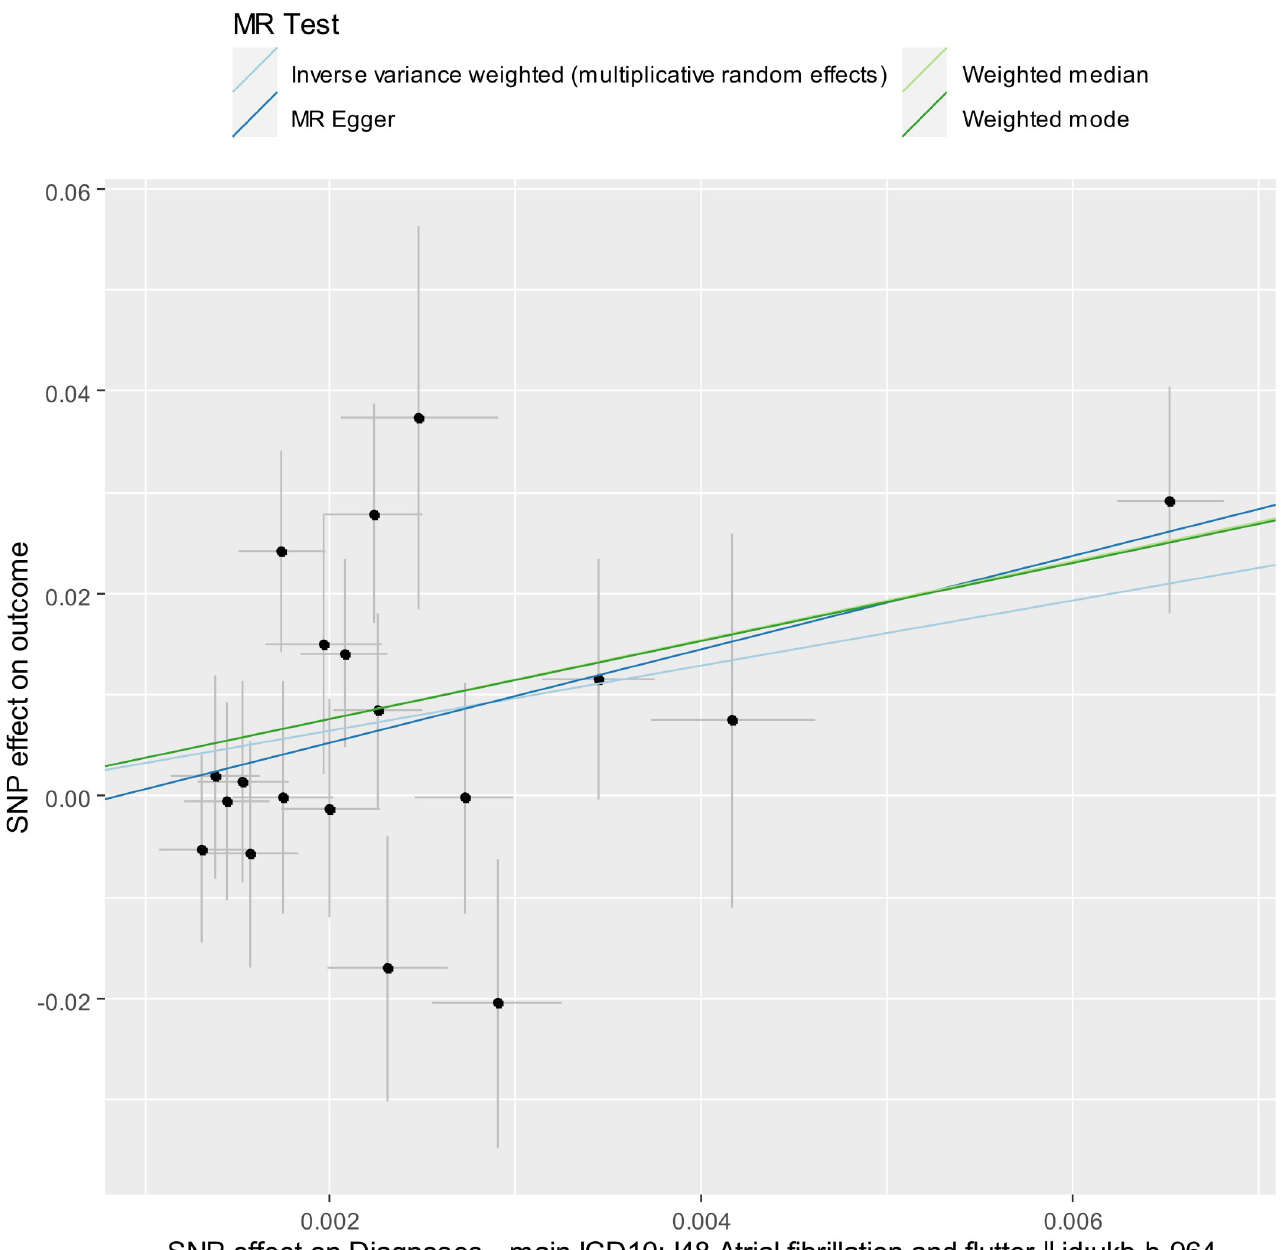
Fig 2. Scatter plot for estimating the causal effect of the risk of AF/F on the risk of